Question: Does the figure show an increasing or a decreasing trend?
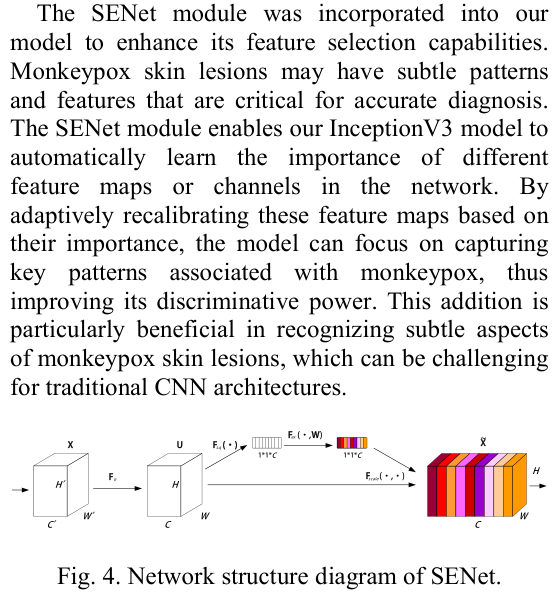
Answer: decreasing